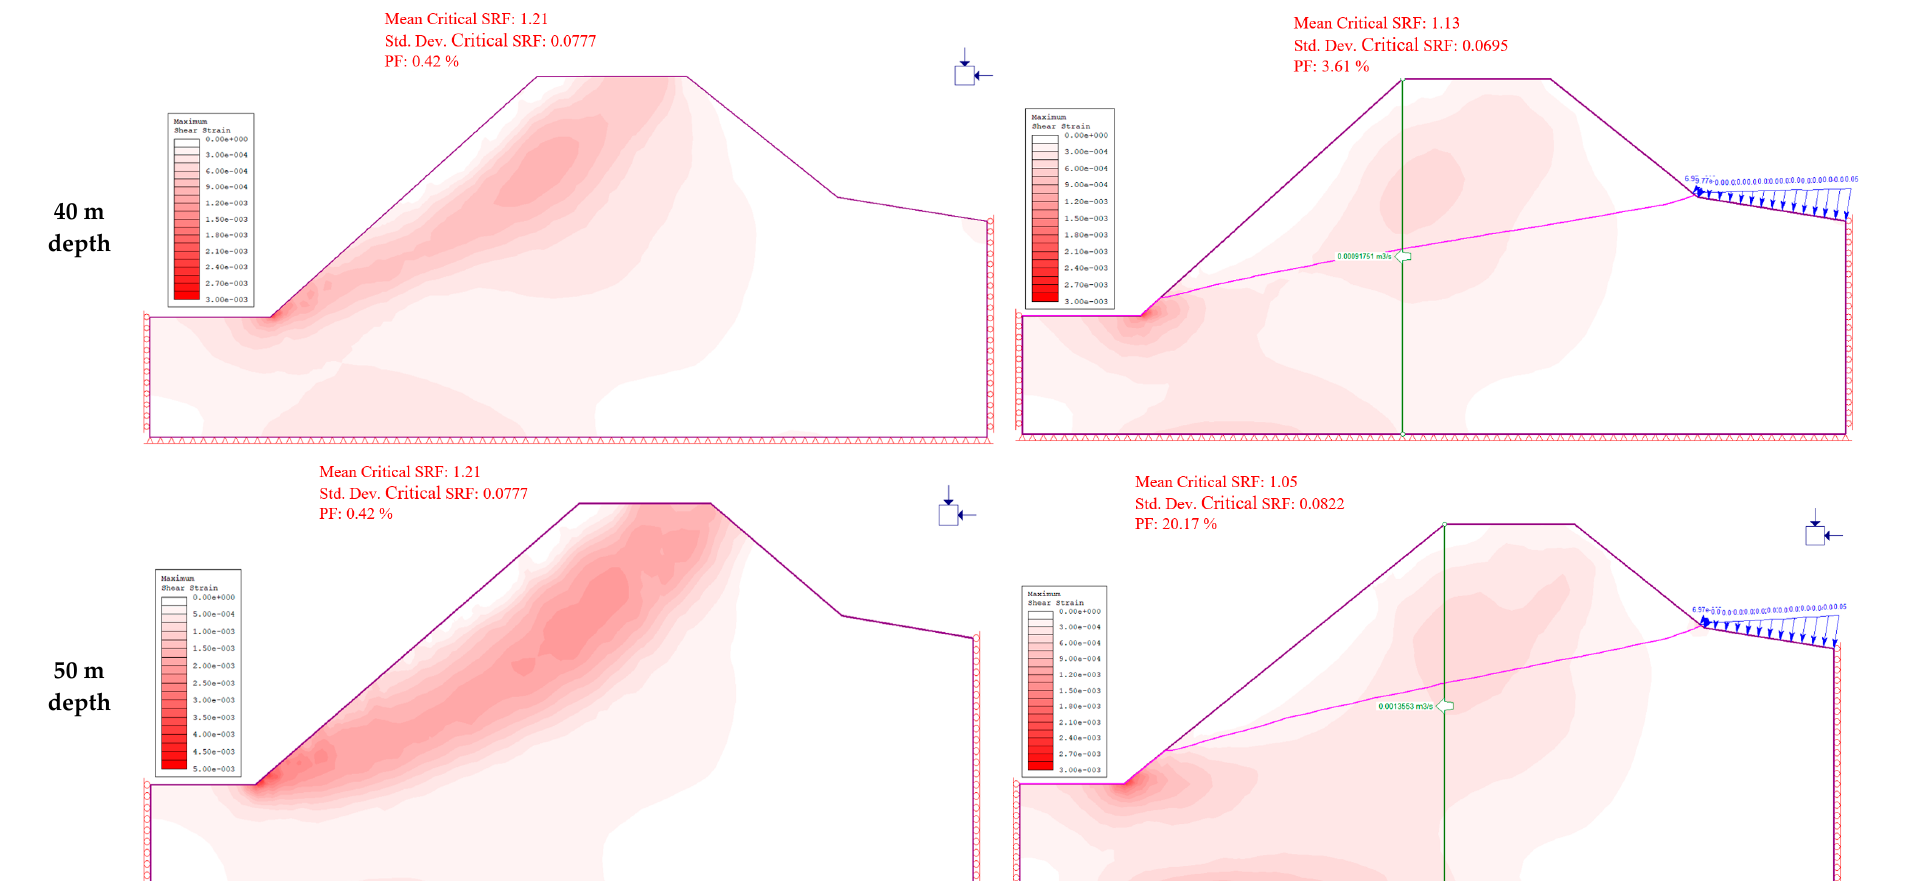
Figure 12. Changes in slope safety factor at 50 m from the shoreline.